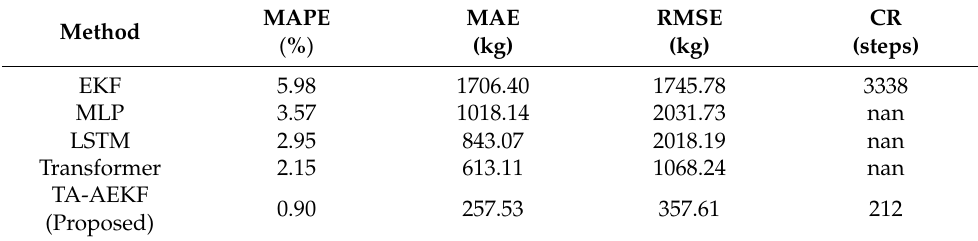
Table 3. Evaluation metrics of simulation test 2 results.